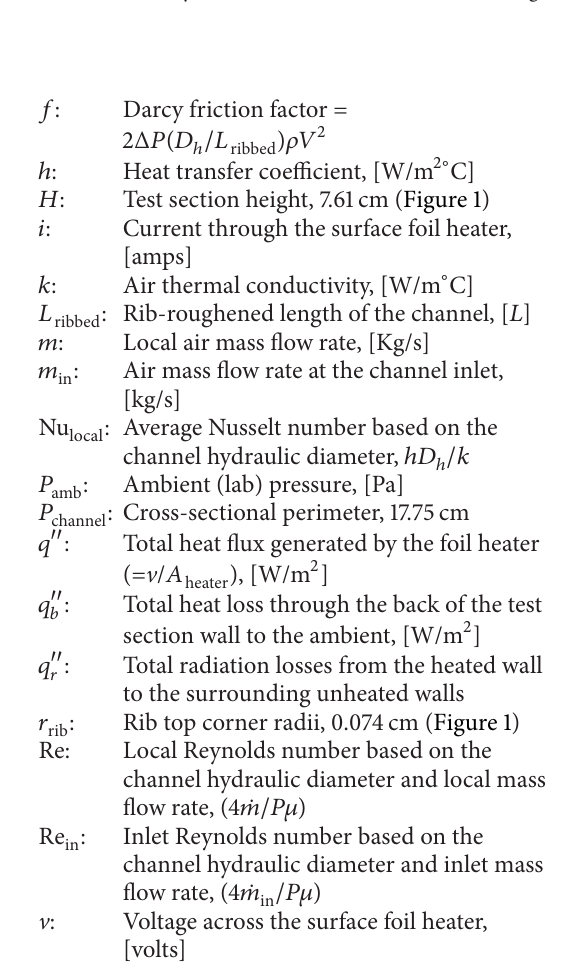
Figure 20: Darcy friction factor variation for all tested